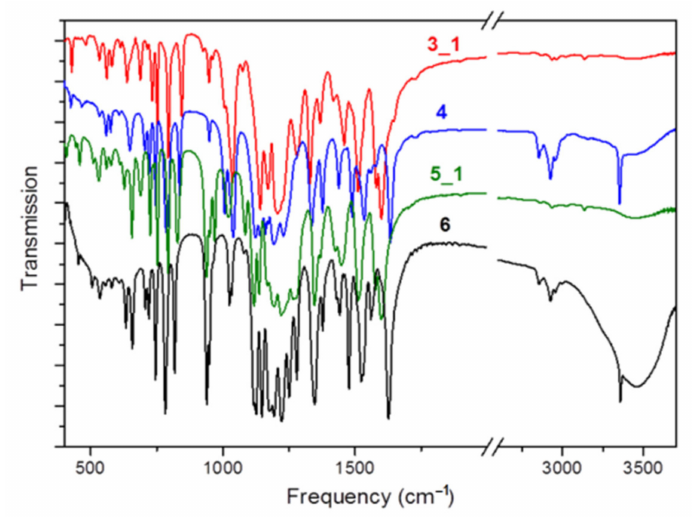
Figure 2. Experimental IR spectra of complexes 3 – 6